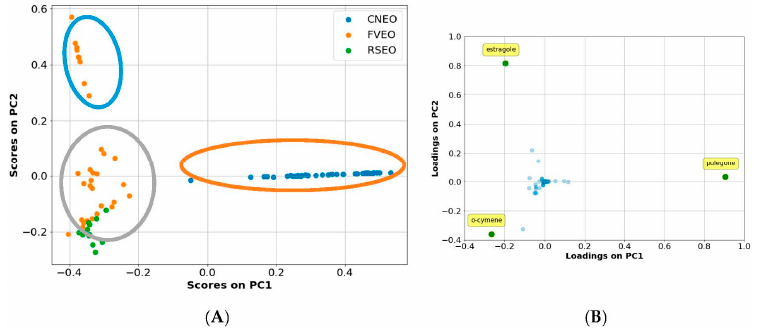
Figure 2. PCA first 2 PCs graphical plots. The core plot ( A ) indicates the presence of at least three clusters (circled in ( A )). The loading plots ( B ) highlights that estragole, o-cymene, and pulegone could be the most important chemical constituents among all the tested